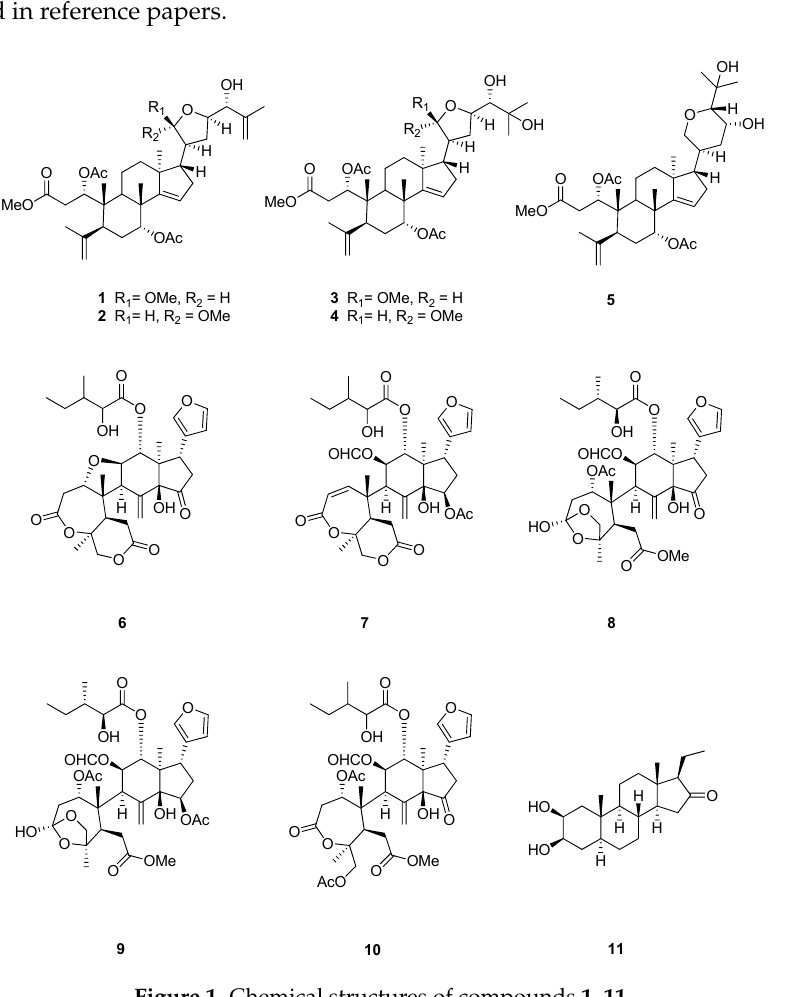
Figure 1. Chemical structures of compounds 1 – 11 .